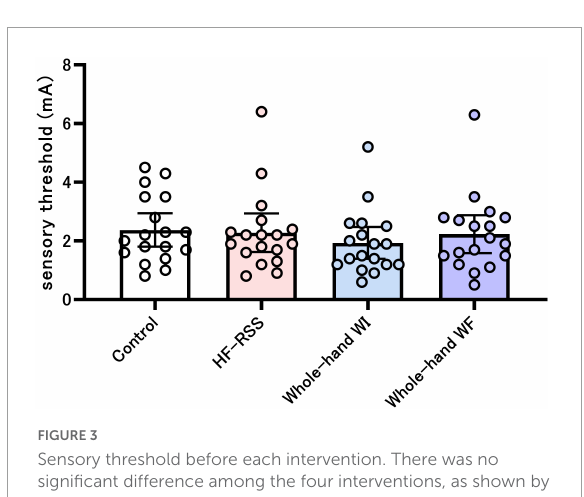
FIGURE3 Sensory threshold before each intervention. There was no significant difference among the four interventions, as shown by the Friedman test. HF-RSS, high-frequency repetitive somatosensory stimulation.